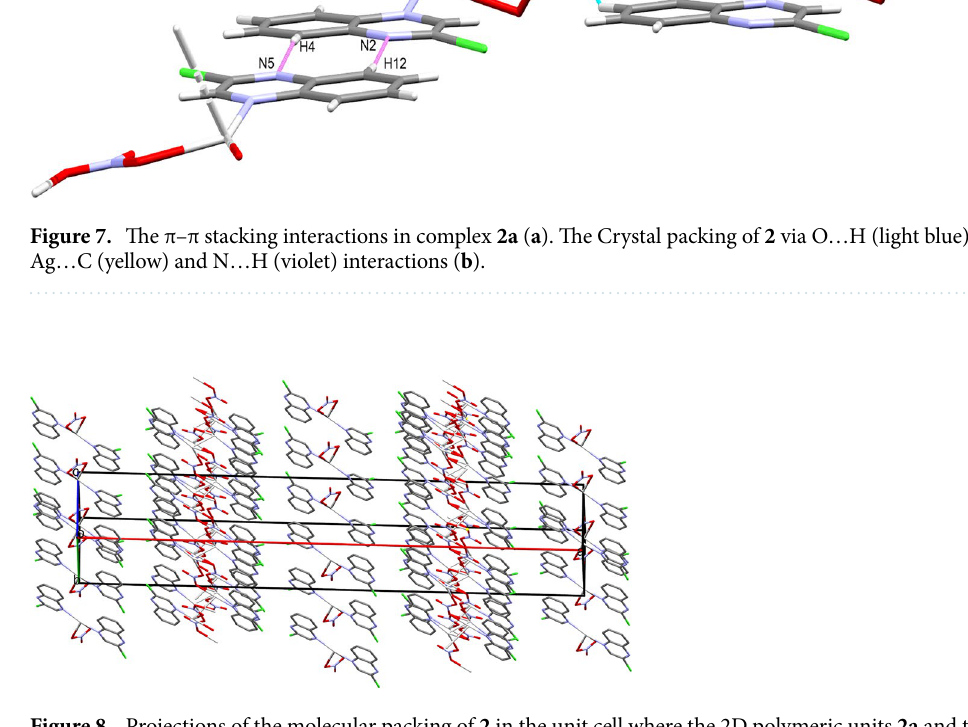
Figure 8. Projections of the molecular packing of 2 in the unit cell where the 2D polymeric units 2a and the monomeric complex 2b are arranged alternatively. All hydrogen atoms are left out from this figure for better